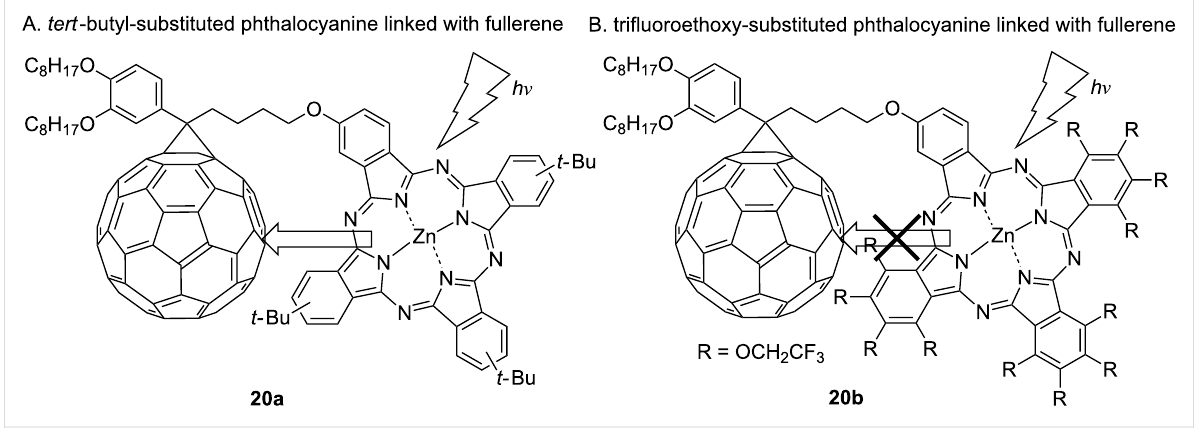
Figure 6: Direction of energy transfer of phthalocyanine–fullerene